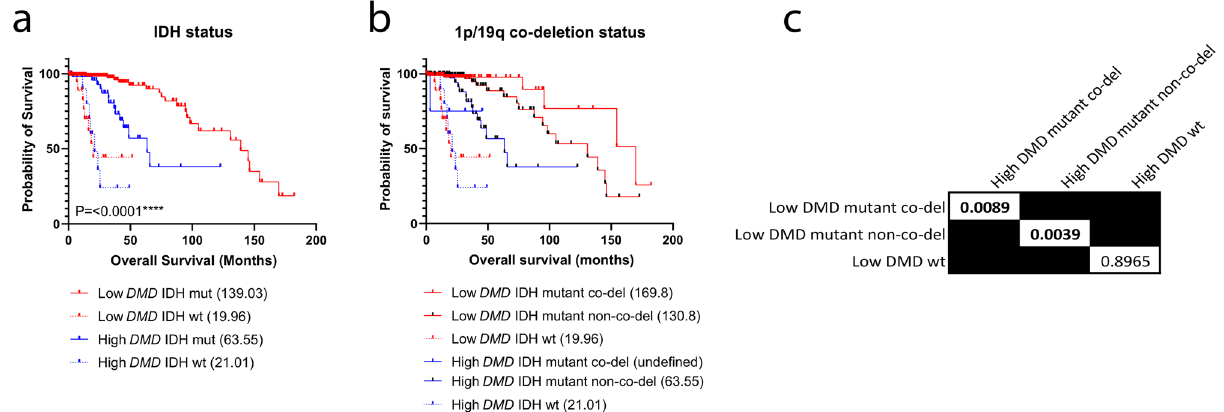
Figure 2. Pairwise comparison of Kaplan–Meier curves identifies a subgroup of IDH mutated LGG patients with poor survival. The Kaplan–Meier survival curves for high (blue) vs low (red) DMD expression for ( a ) IDH mutation status and ( b ) 1p/19q co-deletion status were compared. Numbers in brackets are median overall survival times in months. The table provides the log-rank test P values for each planned comparison from ( b ); the alpha value was adjusted to 0.017 to correct for multiple testing.